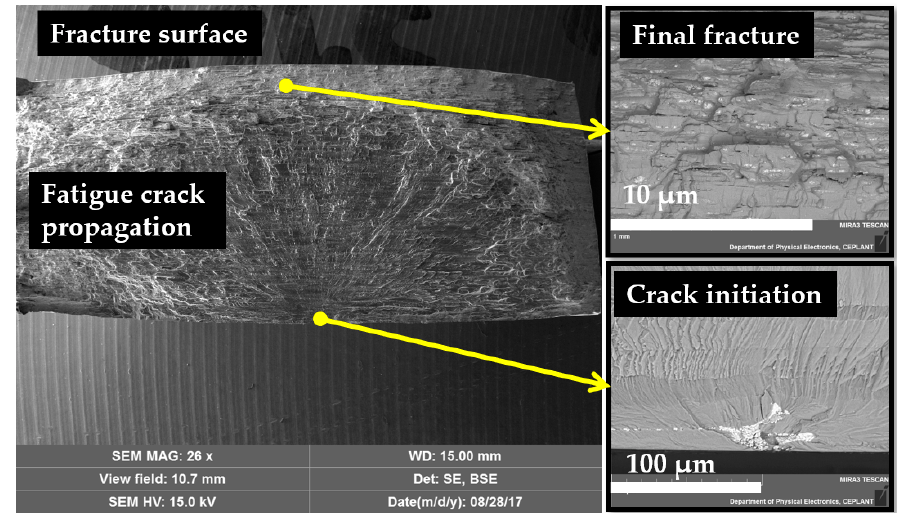
Figure 20. Fracture surface for a specimen machined with the following parameters: f z = 0.90 mm and v c = 90m.min − 1 , stress level 250 MPa.